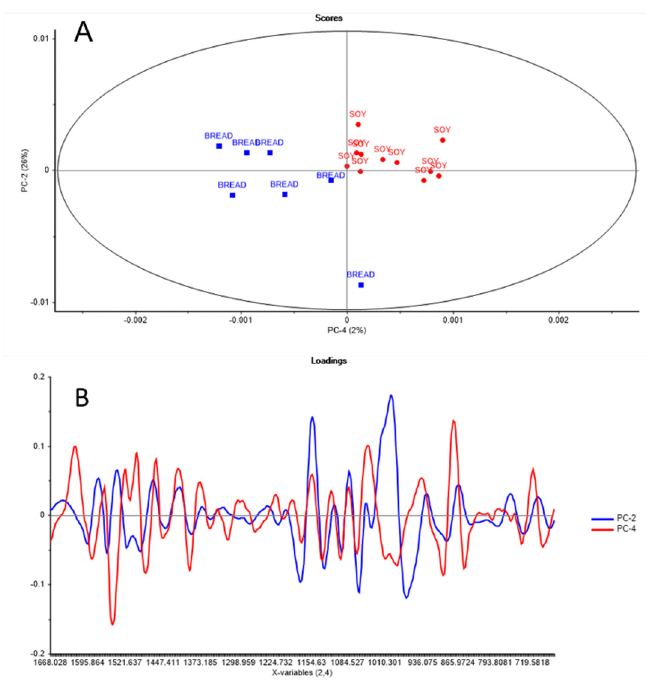
Figure 3. Principal component score of the combined set of instars (5th and 6th), frass samples, and type of waste (diet) analyzed using attenuated total reflectance mid-infrared spectroscopy. Panel ( A ) samples marked by source (instar vs frass); panel ( B ) samples marked by type of waste stream.